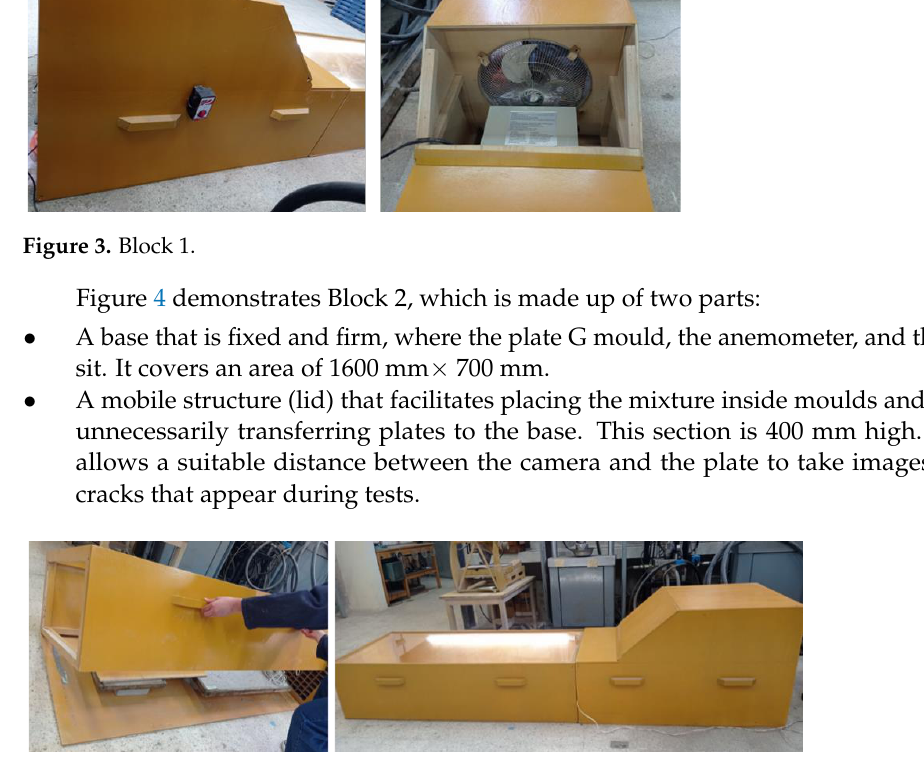
Figure 2. Hot air chamber components: ( a ) Block 1; ( b ) Deep grid; ( c ) Block 2.